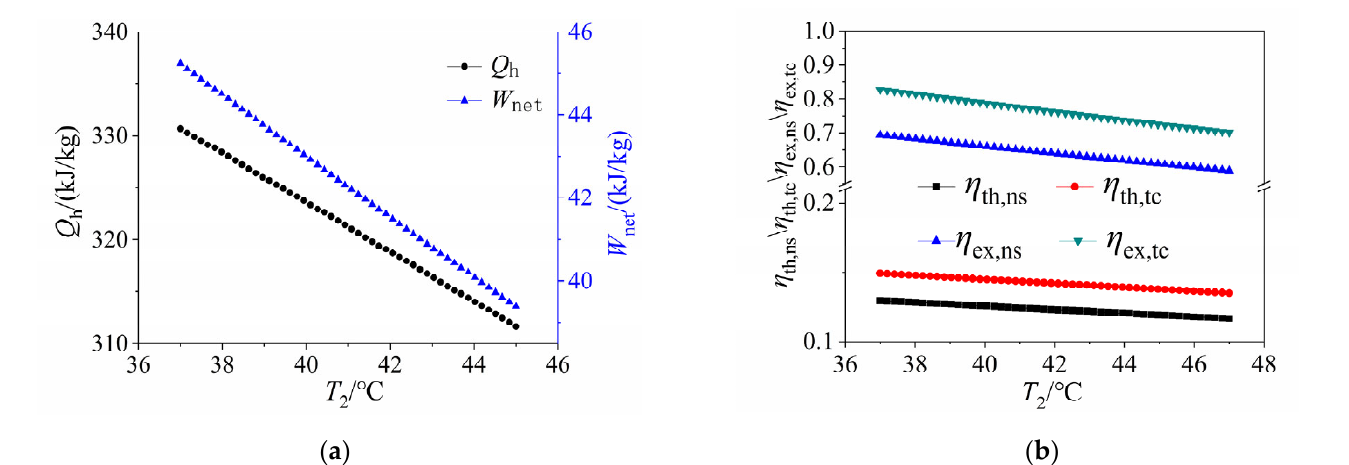
Figure 2. The variation of thermodynamic performance with T 2 : ( a ) Q h and W net ; ( b ) the thermal efficiency and exergy efficiency by numerical simulations ( η th,ns and η ex,ns ) and those by theoretical calculations ( η th,tc and η ex,tc ).